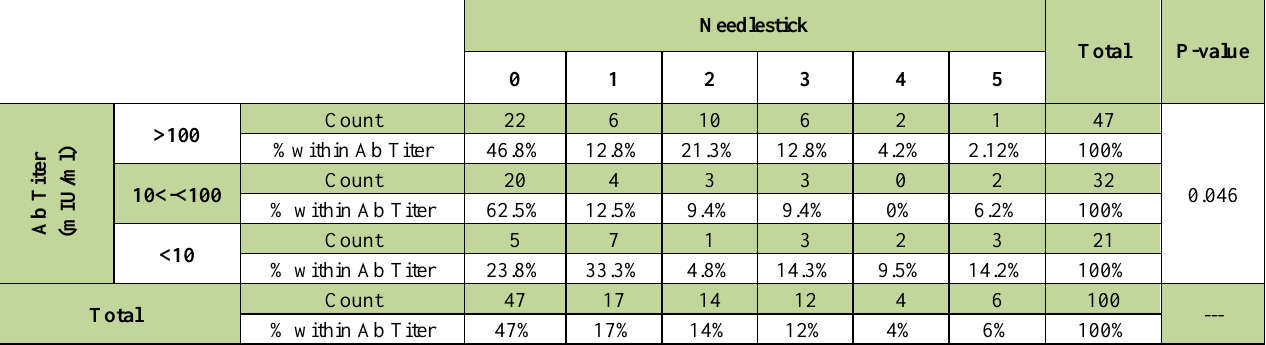
Table 14. Analysis of the relationship between the anti-hepatitis B titration in individuals with the number of the needle stick. Needlestick